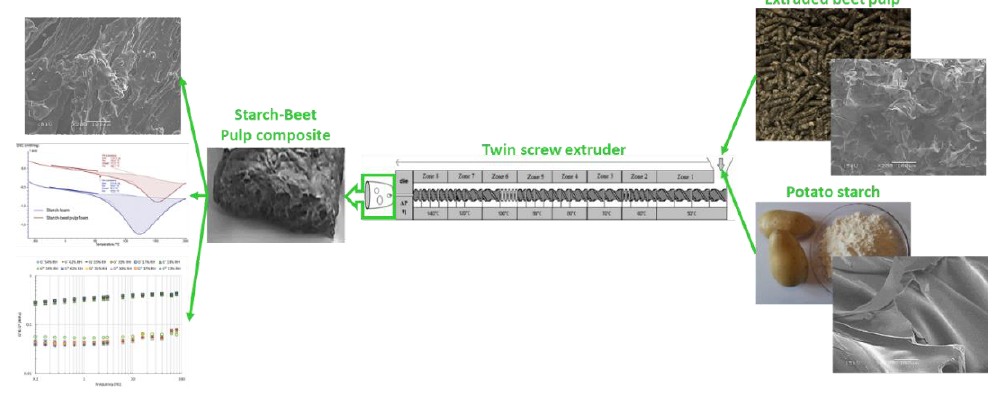
Figure 1. Schematic representation of the overall work.